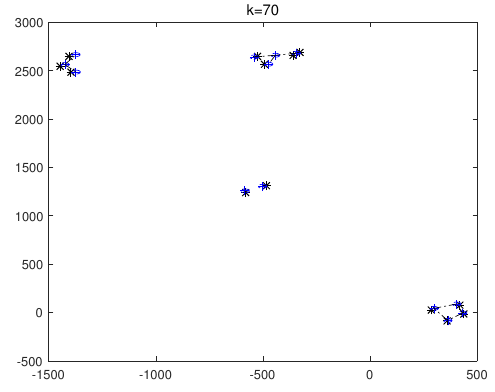
Figure 13. The state estimation of group targets at k = 70.